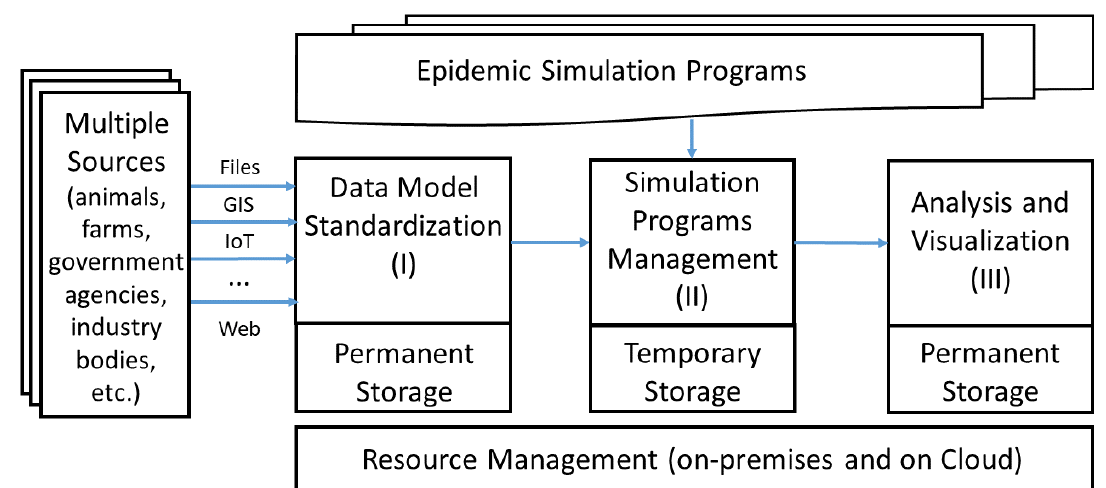
Figure 1. Common architecture for the management and execution of disease outbreak simulation programs in livestock.